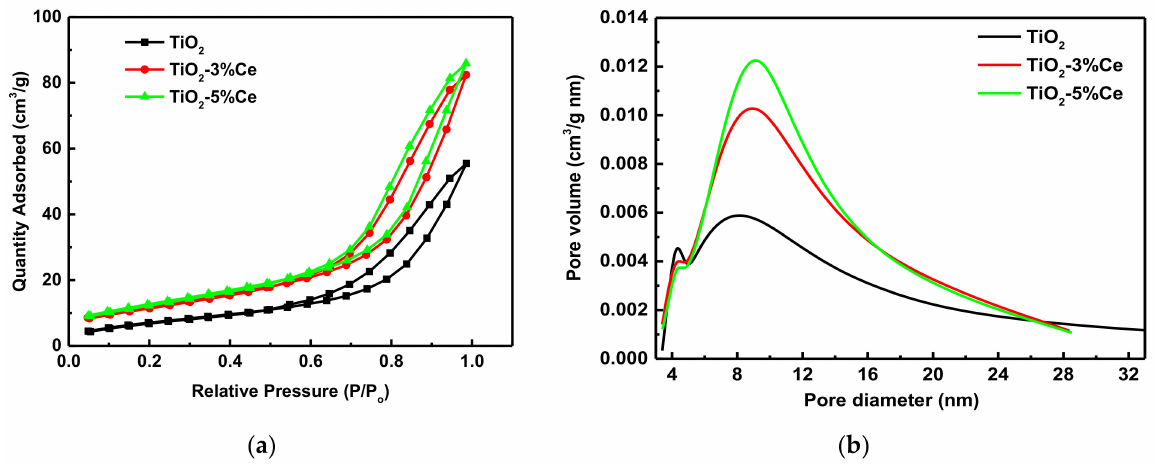
Figure 3. Nitrogen adsorption/desorption isotherms ( a ) and pore size distribution ( b ) of the fibrous pure TiO 2 and TiO 2 –xCe samples. Table 1. Porosity data for the fibrous TiO 2 and TiO 2 –xCe samples.